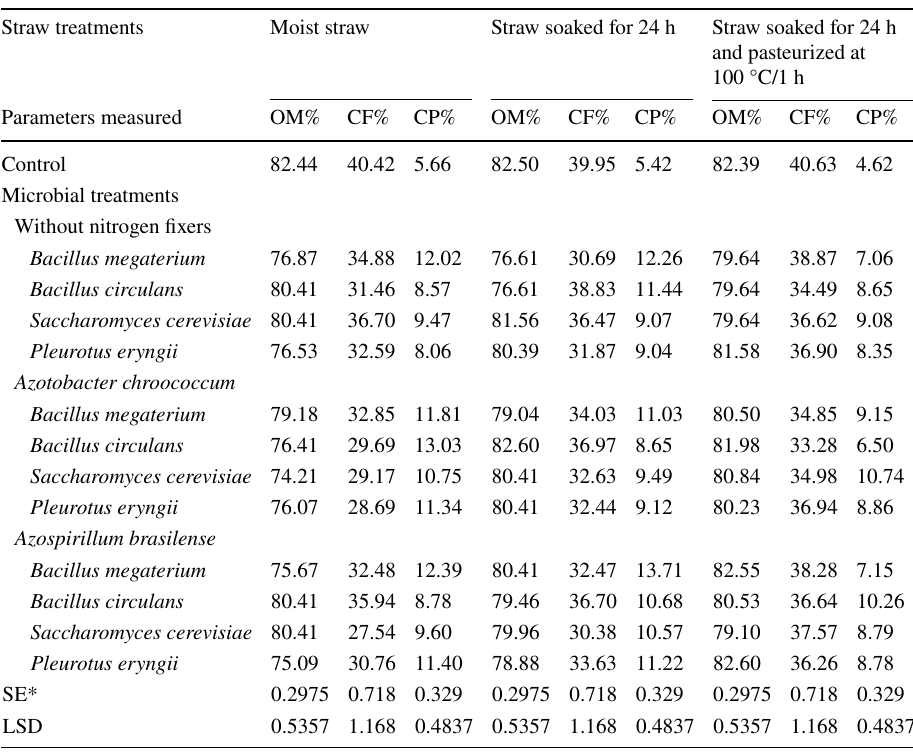
Table 3 Nutritional values of rice straw (ADF and NDF%), affected by combined interactions between different microbial inoculants and some physical